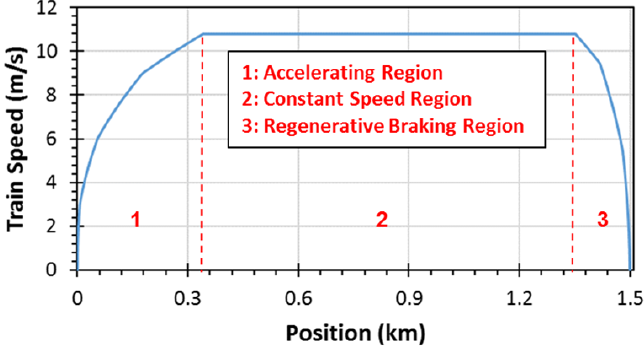
Figure 2. Driving cycle of a train between any two consecutive virtual stations on the track.